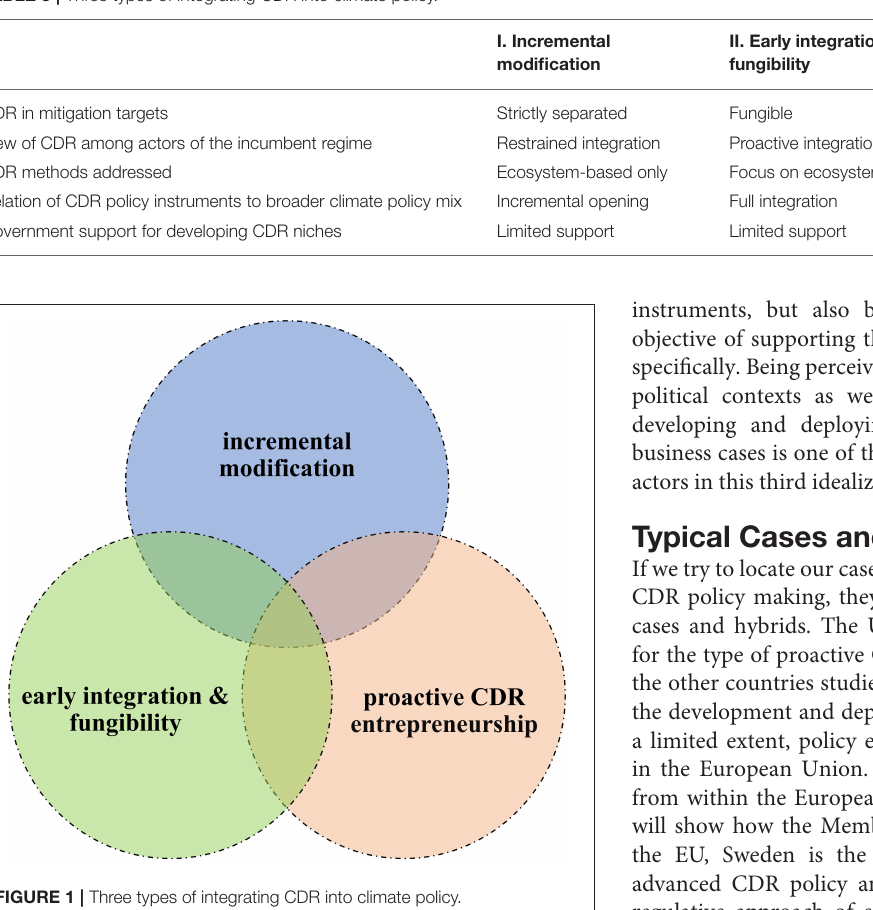
TABLE 3 | Three types of integrating CDR into climate policy.